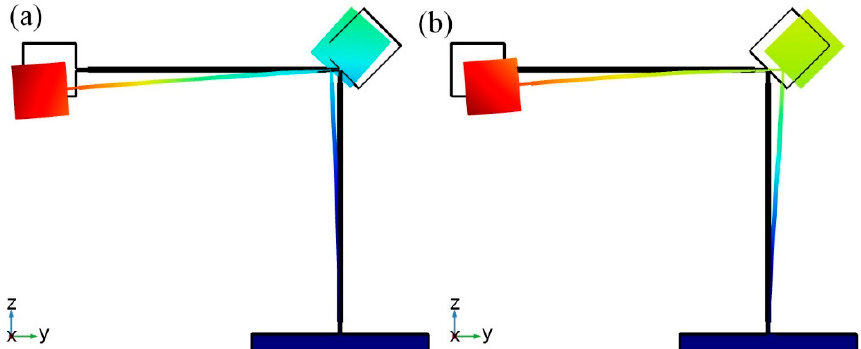
Figure 2. Vibration modes of the harvester with initial parameters; ( a )—modal shape at 29.858Hz; ( b )—modal shape at 41.257Hz.